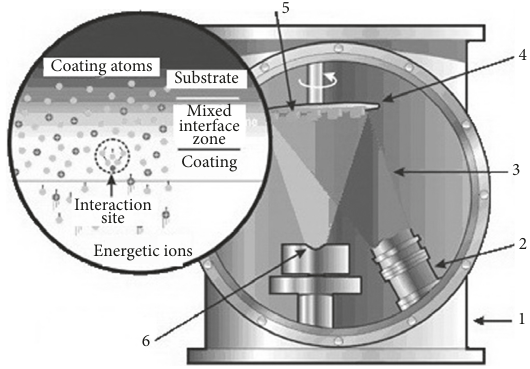
Figure 1: IBAD process: vacuum chamber (1), ions source (2), energetic ions (3), rotating substrate holder and monitor (4), components (5), and electron beam evaporator